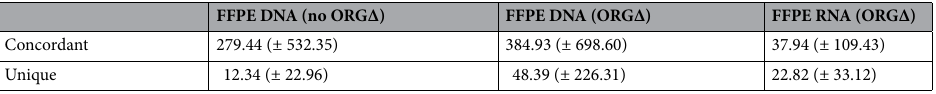
Table 2. Average genotype quality scores for FFPE samples. Genotype quality scores for FFPE samples were averaged for SNPs marked as in agreement with the corresponding frozen sample SNPs (concordant) or unique to the FFPE samples. Standard deviation values are given in parentheses. ORG∆ indicates organocatalyst-treated samples. FFPE data were combined from 12-h kidney FFPE, 12-h ovary FFPE, and 72-h ovary FFPE samples.